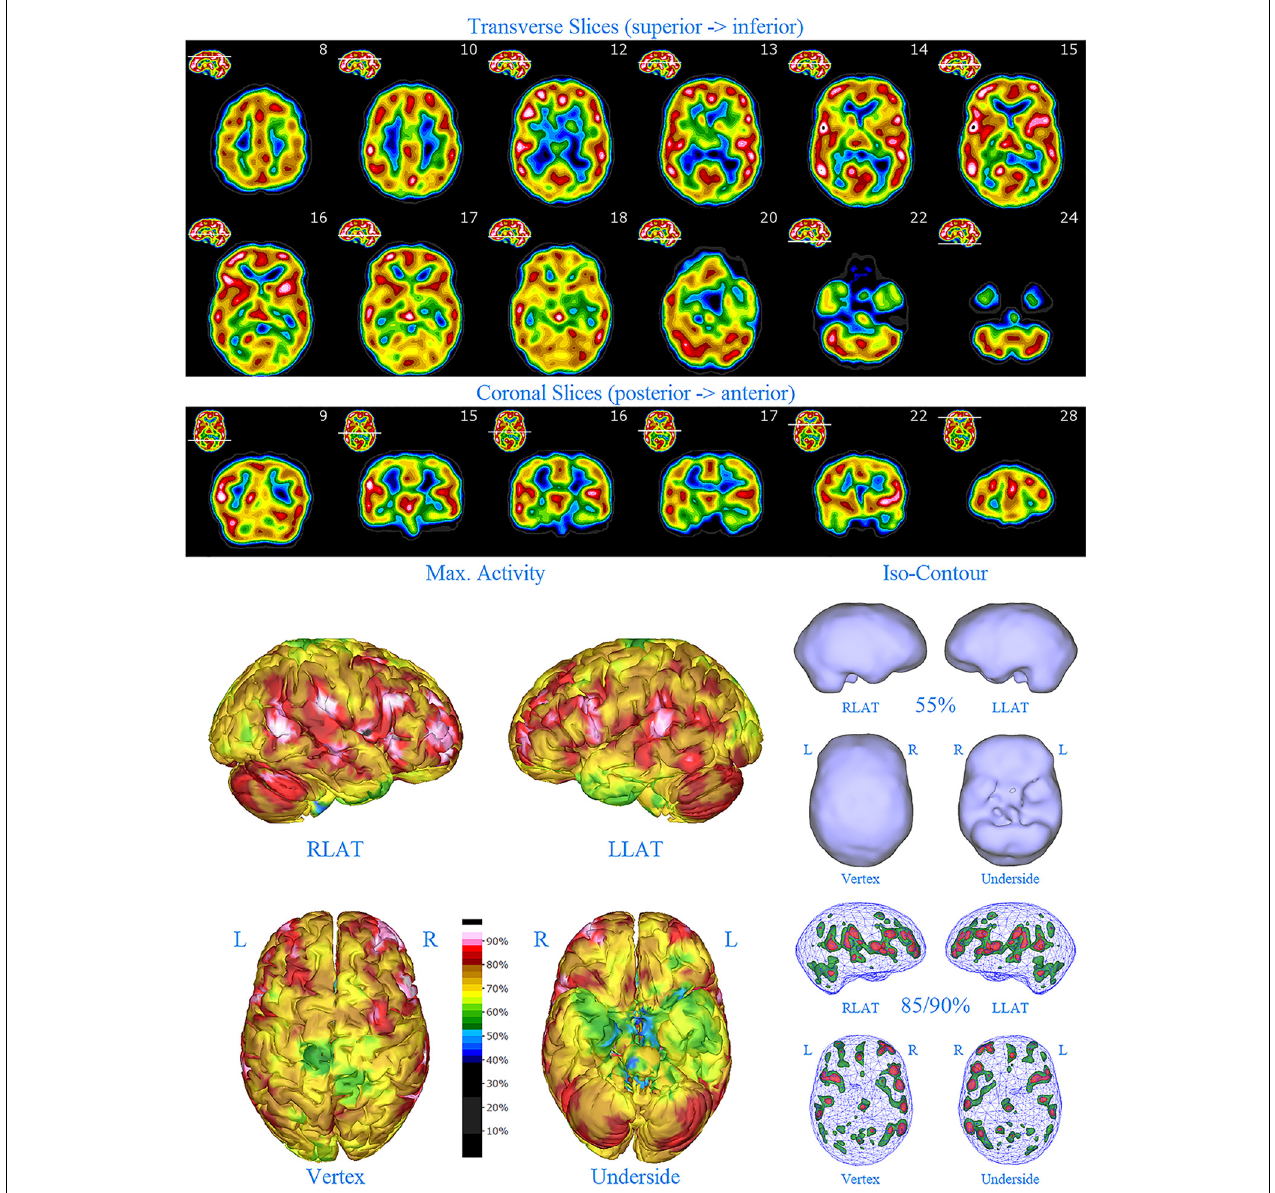
FIGURE 5 | Second perfusion SPECT scan of Patient C. Arrangement, color scales, and views are identical to Figure 1 . Anatomical structures such as the thalamus are positioned similarly to the scan shown in Figure 2 . Labeling was eliminated to avoid obscuring the scan details. Perfusion of the thalamus is increased and asymmetrical. Multiple areas of markedly increased perfusion are found throughout the cerebral cortices. Also, areas of cortical hypoperfusion can be seen in the parietal cortices bilaterally (green on the 3-dimensional